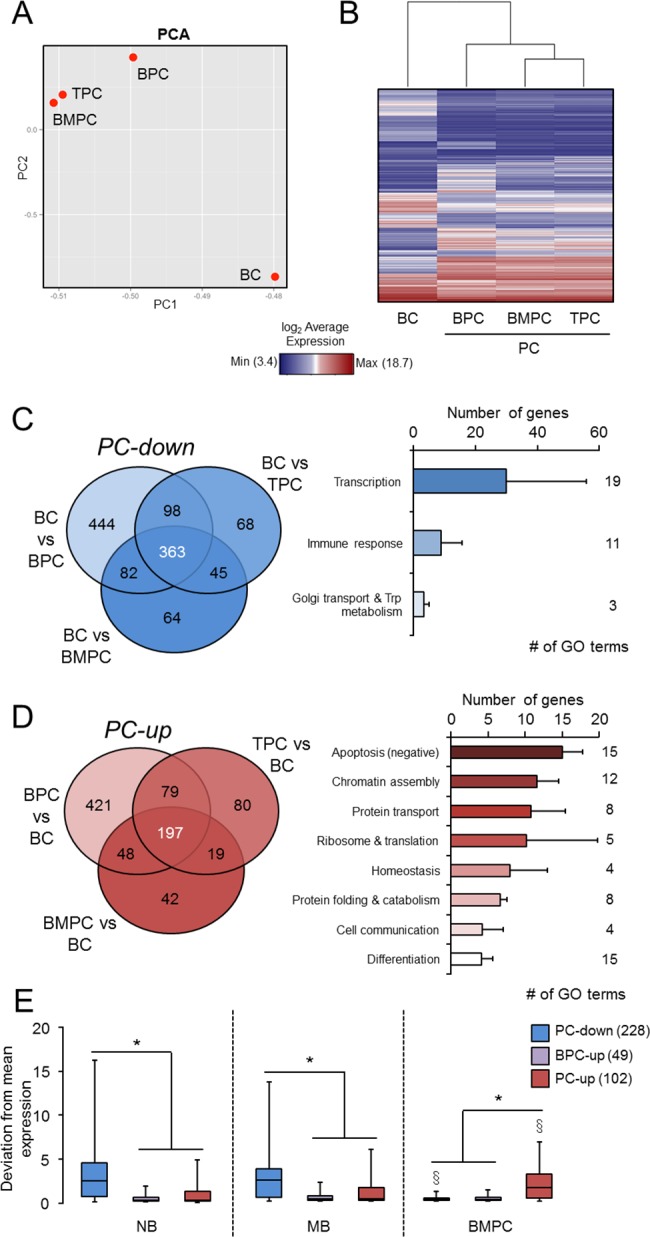
Human B-cell maturation into PC produces distinctive signatures.(A) Principal Component Analysis (PCA) of the whole transcriptomes of BC, TPC, BPC and BMPC. (B) Heatmap of the average expression of differentially expressed probesets (adj. P-value < 0.1) in any pair-wise comparison. (C) PC-down signature. Left, Venn diagram showing the down-regulated genes in each PC compared to naïve BC: the central number represents the PC-down signature. Right, GO enrichment analysis of PC-down signature (P< 0.05, DAVID), in which the number of genes represents the mean ± SD of the genes contained in the GO terms within the indicated functional categories. (D) PC-up signature. Left, Venn diagram showing the up-regulated genes in each PC compared to naïve BC: the central number of the diagram represents the PC-up signature. Right, GO analysis as in (C) for the PC-up signature. (E) Box-and-whisker plots of the PC-down, BPC-up and PC-up genes that overlapped with the subset defined in GenomicScape as those genes with the highest deviation from average expression among naïve BC (NB), memory BC (MB) and BMPC from the resource [20]. Numbers of overlapping genes are in brackets in the color legend. For clarity, outliers have been removed. *, P < 0.05 in Student’s t-tests between signatures within the same GenomicScape cell subtype; §, P< 0.05 Student’s t-tests between each cell subtype and NB within the same signature.